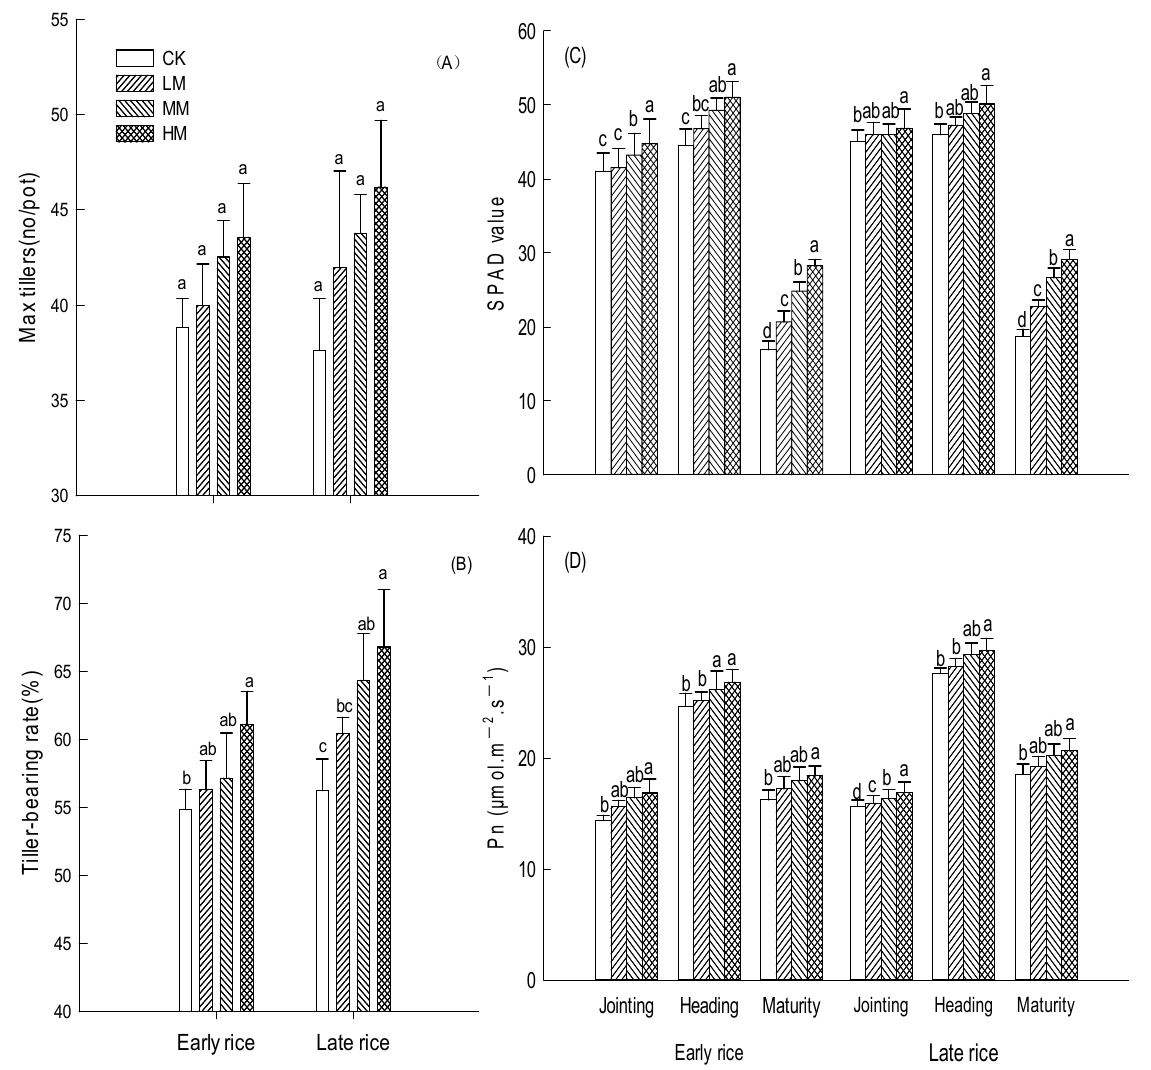
Figure 2. Max tillers ( A ), tiller-bearing rate ( B ), SPAD ( C ), and Pn ( D ) of the double cropping rice under different treatments (2018). LM, MM, and HM denote low-, middle-, and high-concentration MNBs, respectively. CK denotes the ordinary running water. The vertical bars represent ± SE of the mean. The SE was calculated across three replications. Different letters indicate statistical significance at p < 0.05.